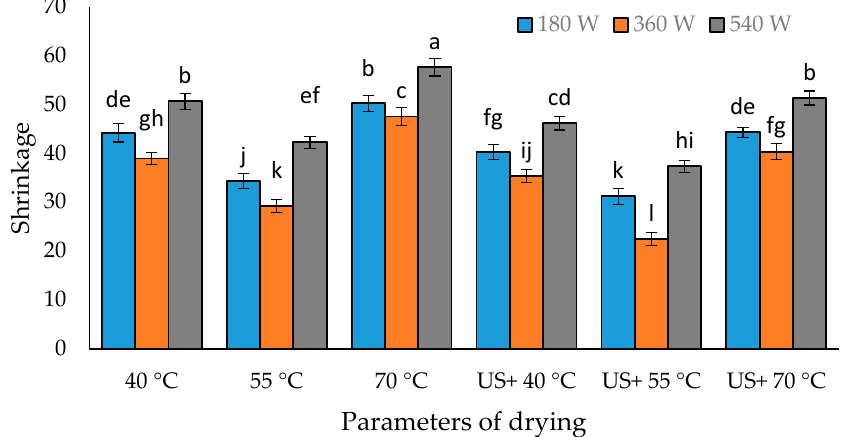
Figure 4. Effects of US pretreatment, MW power and air temperature during drying on shrinkage of hawthorn. Data followed by different letters (a–l) in each column are significantly different at p < 0.01. Columns with the same letters are not significantly different.